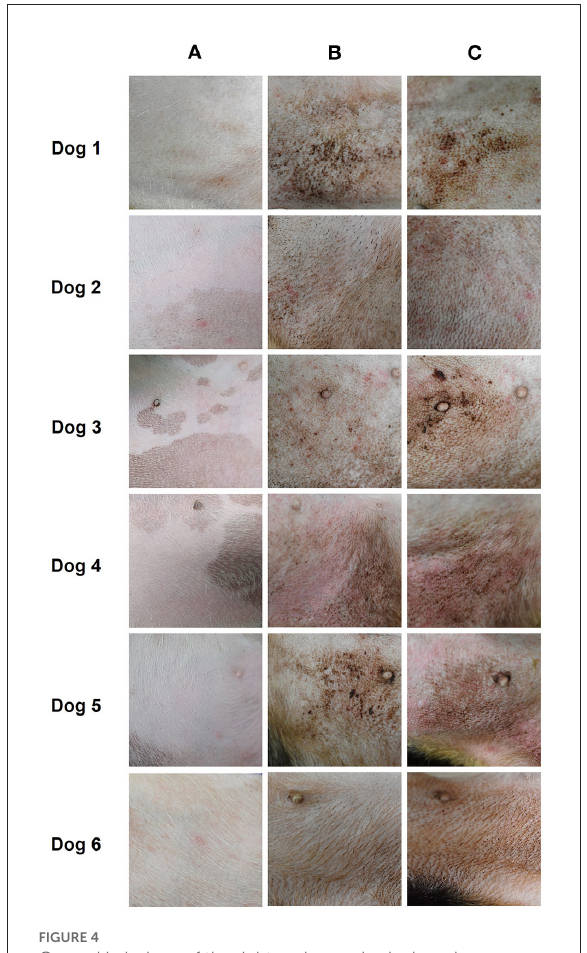
FIGURE4 Gross skin lesions of the right groin area in six dogs. Images show the time course of development of the skin lesions at (A) pre-sensitization, (B) post-sensitization, and (C) post-provocation.